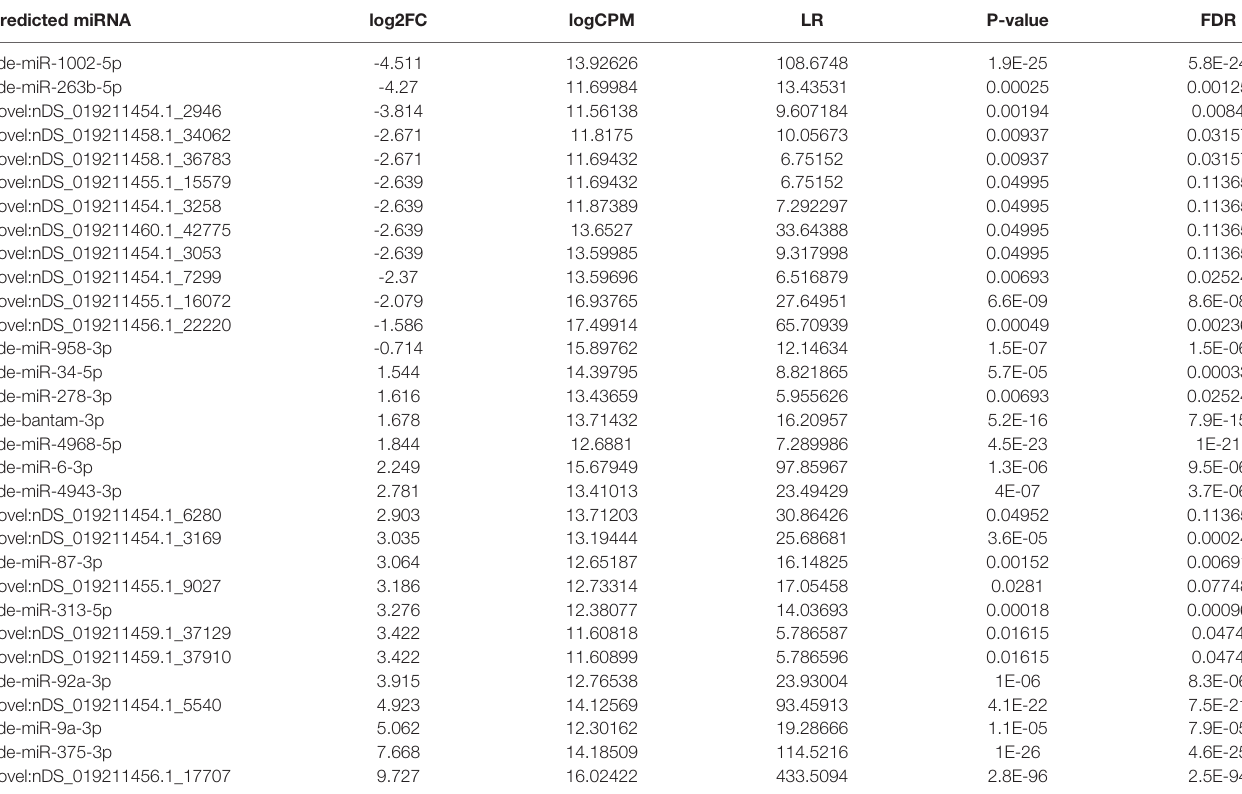
miRNAs with a log2 fold-change in expression > |1| and FDR ≤ 0.1 were considered signi fi cantly differentially expressed with respect to male microRNAs.